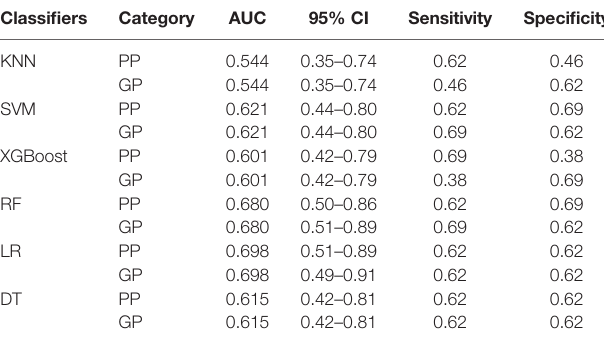
TABLE 1 | General status of subjects. TABLE 4 | ROC results with six classi fi ers of validation set in arterial phase.